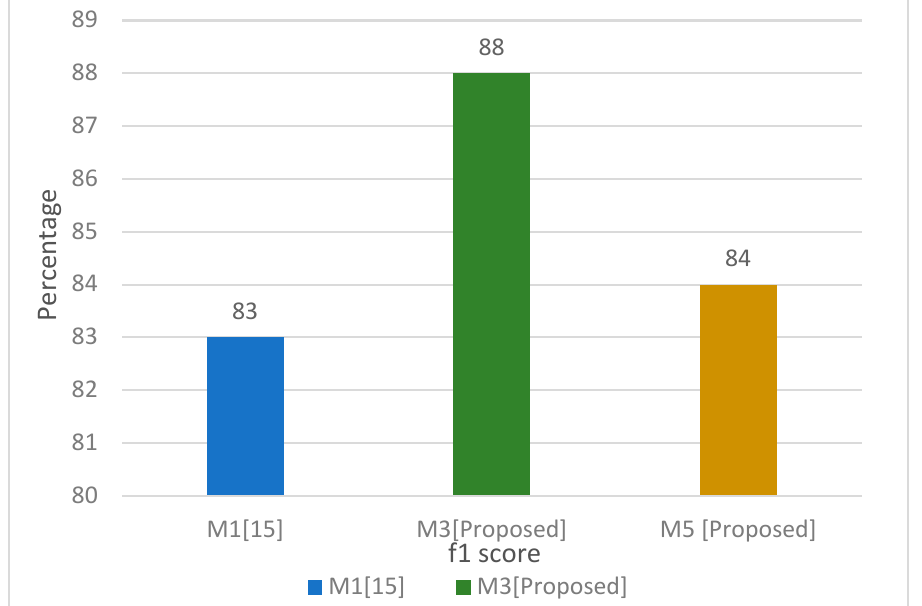
Figure 17. Sadiq, S (2021) Model vs. Best Fit Proposed Models (Bigram + Trigrams) in Terms of F1 Score.